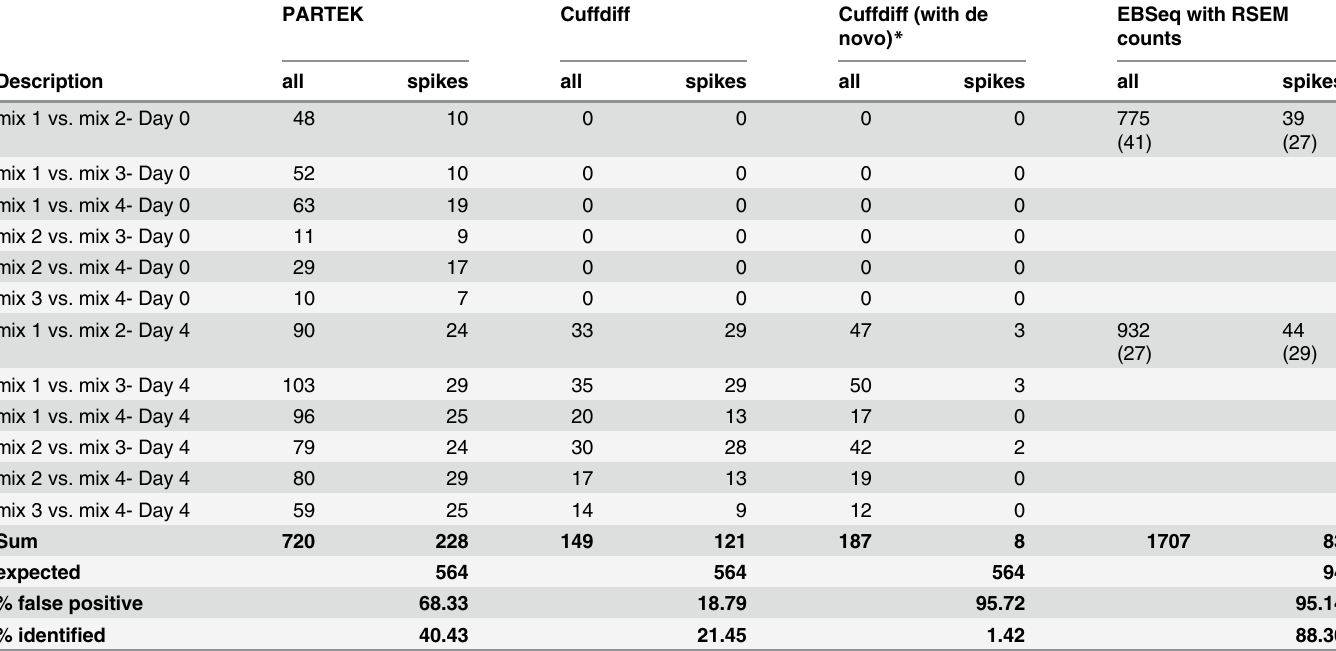
Table 1. Number of differentially expressed transcripts among the mixes, as identified using various bioinformatics tools and RefSeq + annotation.